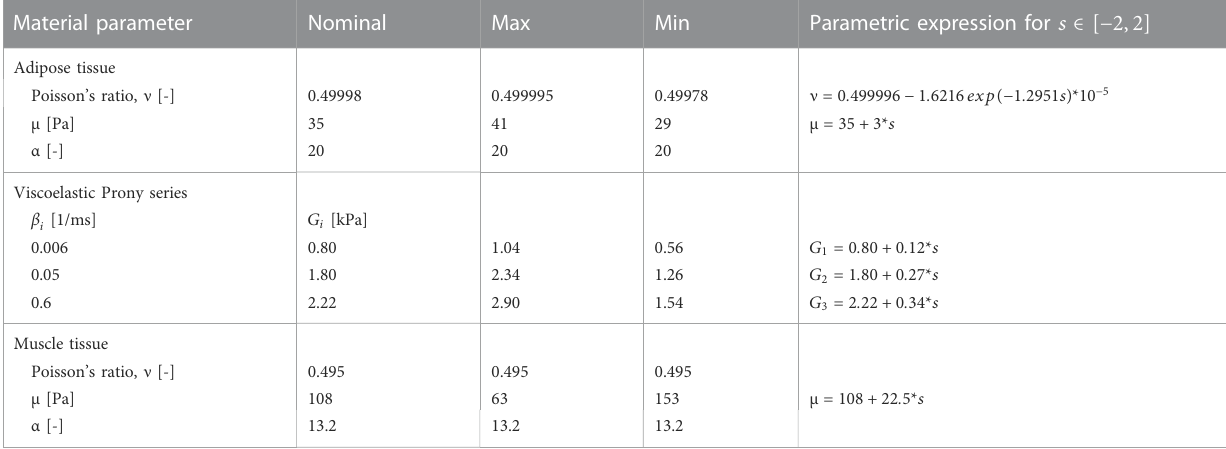
TABLE3LS-dyna*MAT_077_Omaterialparametersforadiposeandmuscletissues.Nominal,maximum,andminimumvaluesandtheparametricexpressionsused to vary the material parameters. Material